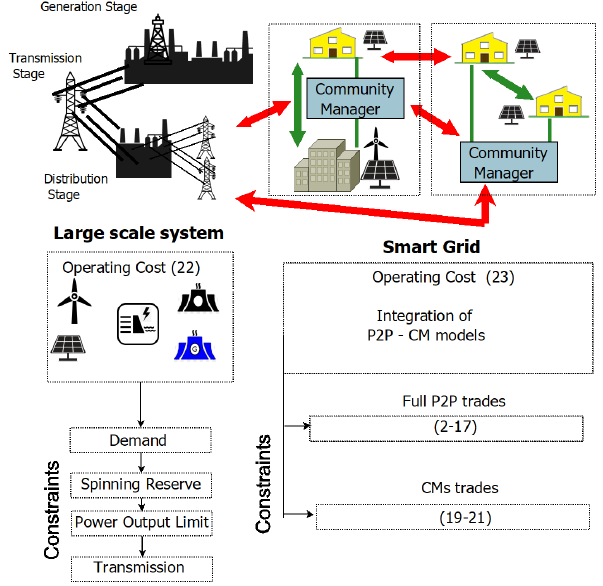
Fig. 4 . Scheme of the model that relates the large-scale system and smart grid. INT